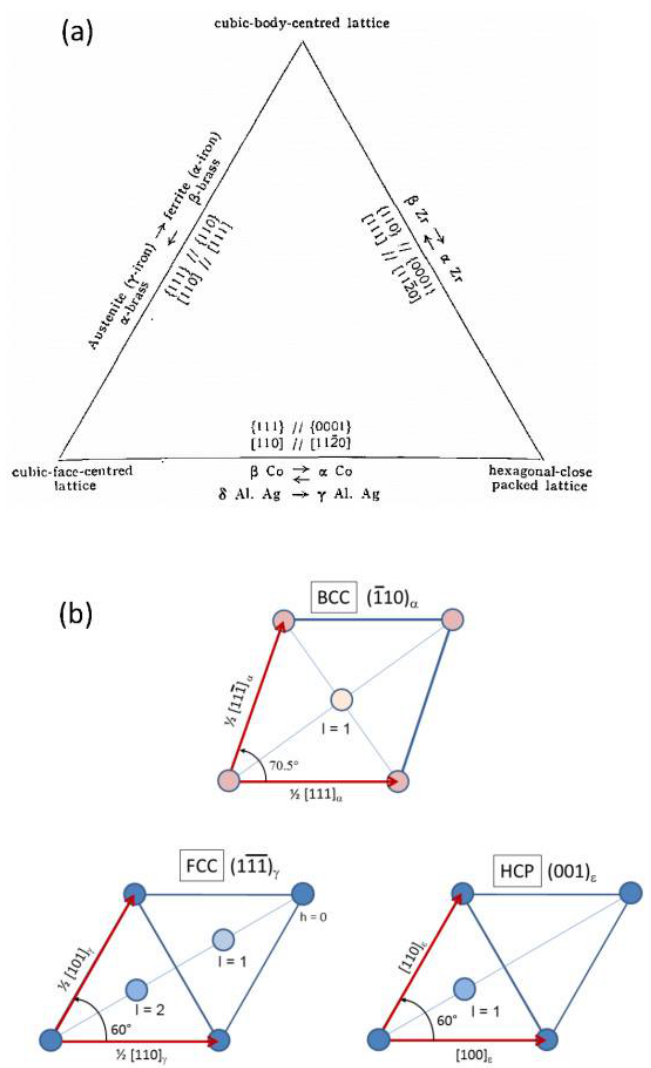
Figure 26. Phase transformations in the fcc-hcp-bcc system. ( a ) As represented by Burgers in 1934 [29]; ( b ) planar representation of the fcc, bcc, and hcp structures. The positions l = 1 and l = 2 represent the level of the atoms in their stacking, perpendicular to the dense planes (111) γ //(110) α //(001) ε . Reprinted from [123] with permission from Elsevier.